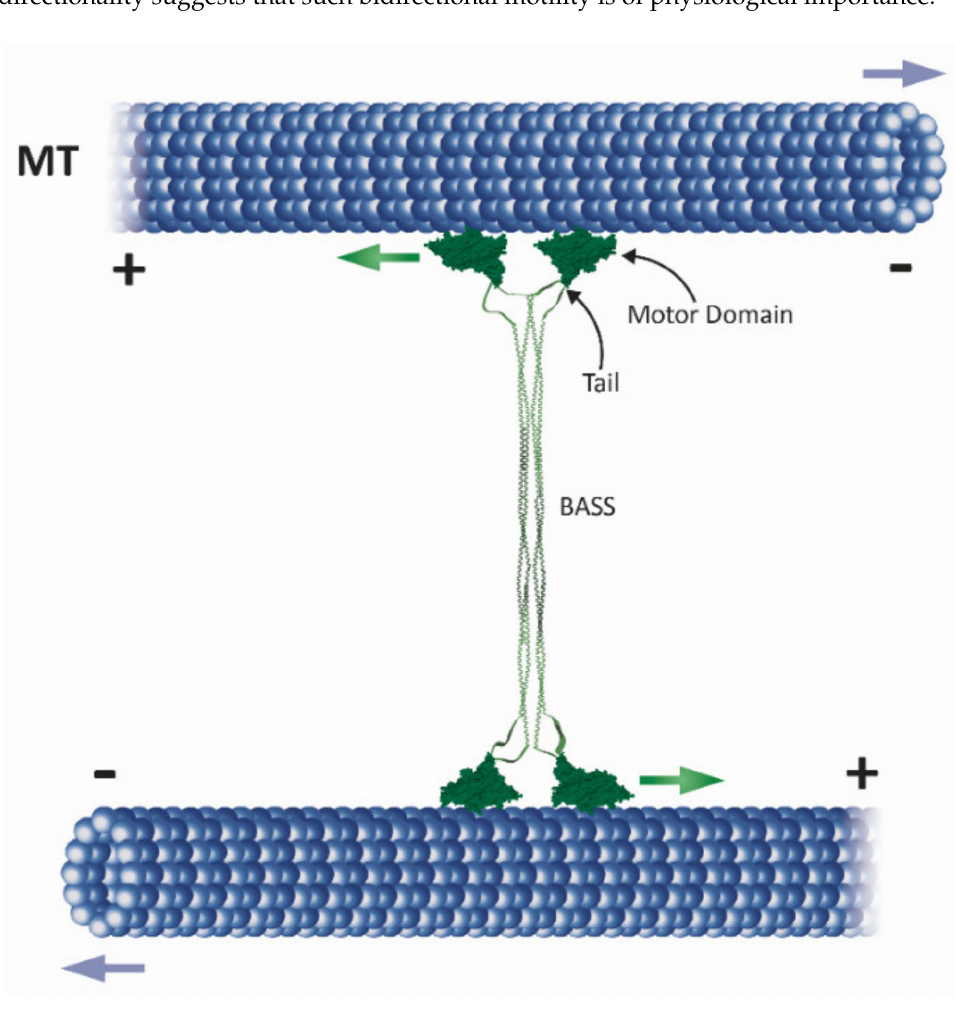
Figure 2. Schematic presentation of how a full-length kinesin-5 tetramer (green) crosslinks and slides apart antiparallel spindle MTs (blue). The globular motor domains and tail domains are located at the ends of the bipolar structure, connected through the central stalk which includes the bipolar-assembly (BASS) domain in the middle region [37,38]. The pair of motor domains at each end interacts with one of the two anti-parallel MTs and hence crosslinks and slides them apart. Green arrows indicate the plus-end direction of kinesin-5 motor domain movement on the MTs, while purple arrows indicate the direction of MT movement during anti-parallel sliding, with minus ends leading. Within the spindle, MT minus ends are concentrated near the spindle poles. Thus, kinesin-5 induced antiparallel MT sliding separates the spindle poles